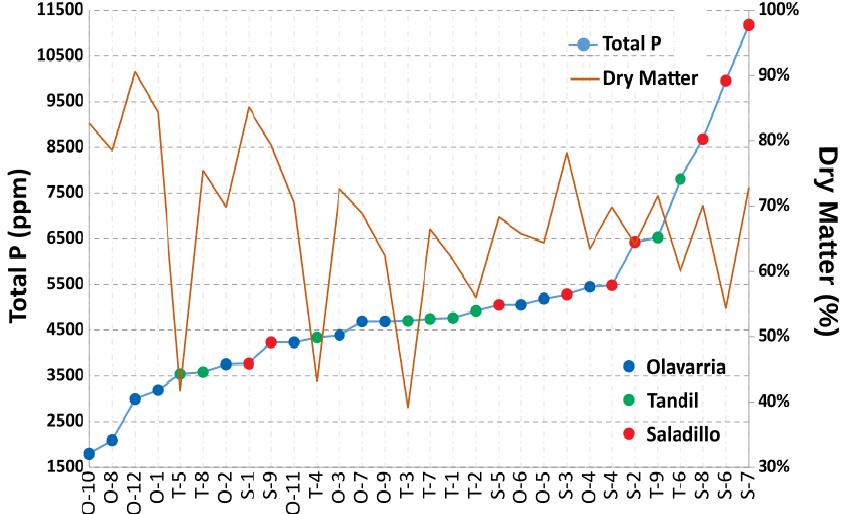
Fig. 4 Chemically determined total P (left axis) and dry matter content (right) for all